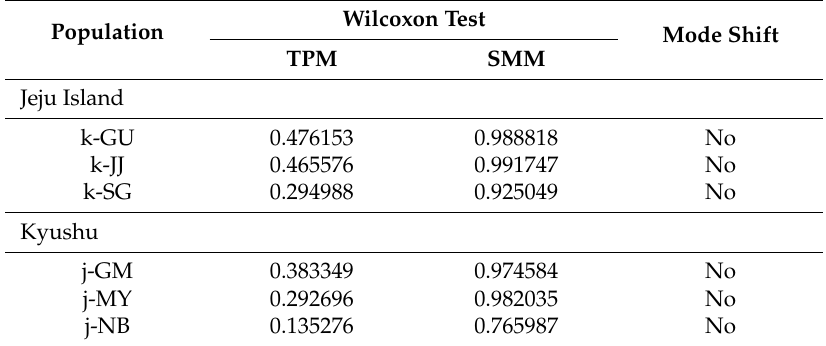
Table 4. Probability of a bottleneck estimated using the program BOTTLENECK for six populations of Quercus gilva, based on the two-phase model (TPM) or stepwise mutation model